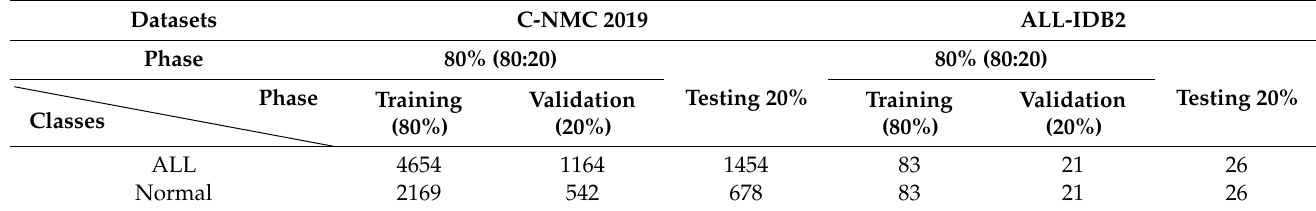
Table 1. Splitting the C-NMC 2019 and ALL-IDB2 datasets.